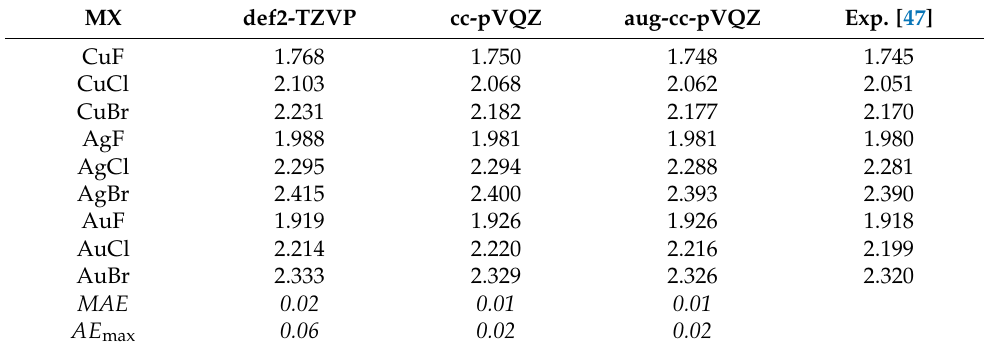
Table 1. Optimized bond lengths of the MX molecules obtained at the CCSD level in combination with different basis sets. The mean absolute error ( MAE ) and the maximal observed absolute error ( AE max ) were calculated with respect to the corresponding experimental values (italic numbers). MX